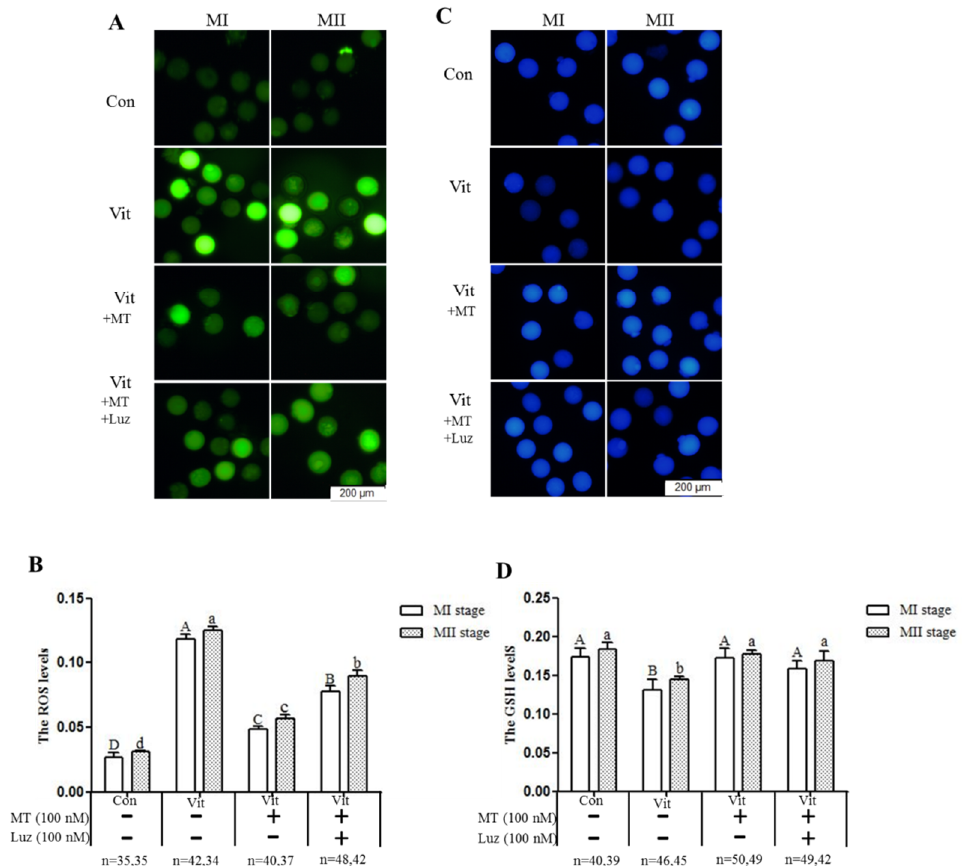
Figure 5. Effects of melatonin (MT) and luzindole (Luz) on ROS and GSH levels during in vitro maturation of vitrified-warmed mouse GV oocytes. ( A ): Representative fluorescence images depicting ROS intensities. ( B ): Quantification of levels of ROS in oocytes. ( C ): Representative fluorescence images depicting GSH levels. ( D ): Quantification of levels of GSH in oocytes. Data are presented as mean ± SEM of four independent experiments. Different superscripts A (a), B (b), C (c) and D (d) indicate differences ( p < 0.05) between groups at the same stages. Scale bar = 200 µm. The four experimental groups: control (Con), vitrification (Vit), vitrification+ melatonin (Vit + MT), and vitrification + melatonin + luzindole (Vit + MT + Luz). Notes: MI: metaphase I; MII: metaphase II.